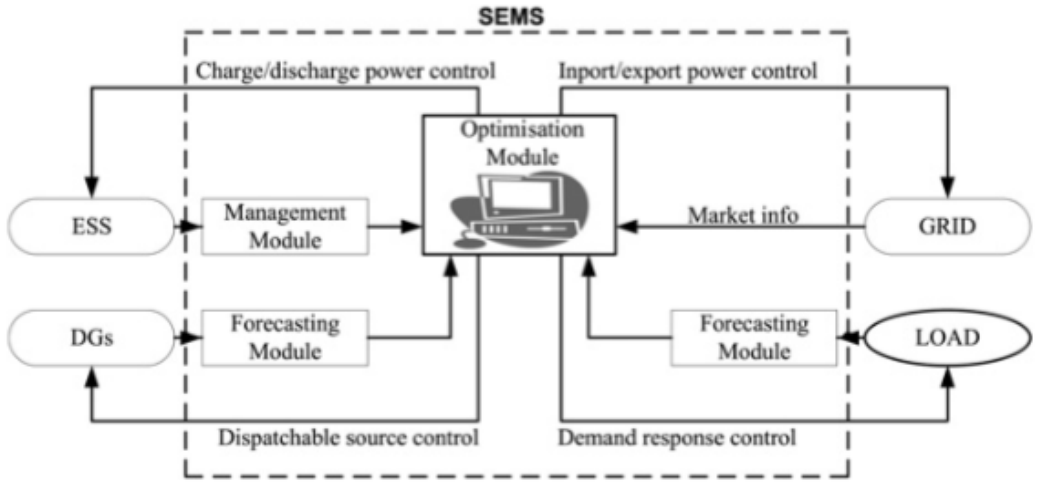
Figure 2. Schematic of inputs and outputs of Smart Energy Management System